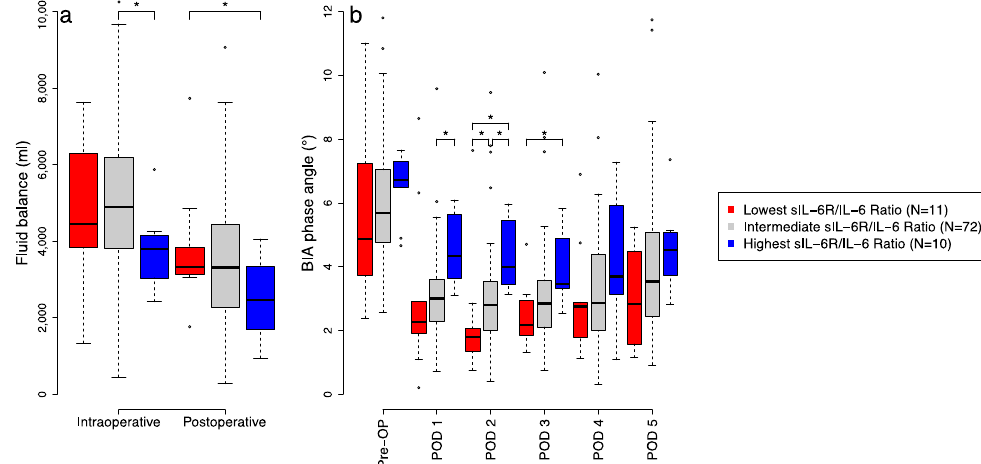
Figure 4. Effects of inflammation on fluid balance and BIA. ( a ) The boxplots show differences in intra- and postoperative fluid balance between patients with continuously highest levels (blue), intermediate levels (grey) and lowest levels (red) of perioperative sIL6-R/IL-6 ratio measured between timepoint 3 and 9. ( b ) The boxplots show differences in phase angle between patients with continuously highest levels (blue), intermediate levels (grey) and lowest levels (red) of perioperative sIL6-R/IL-6 ratio measured between timepoint 3 and 9. Asterisks(*) mark significant differences between the two groups at p less than 0.05. In the boxplots, the lower boundary of the box indicates the 25th percentile, a black line within the box marks the median, and the upper boundary of the box indicates the 75th percentile. Whiskers above and below the box indicate the 10th and 90th percentiles. Points (°) above and below the whiskers indicate outliers outside the 10th and 90th percentiles. Abbreviations: BIA, bioelectrical impedance analysis; CPB, cardiopulmonary bypass; POD, postoperative day; sIL-6R, soluble interleukin-6 receptor.